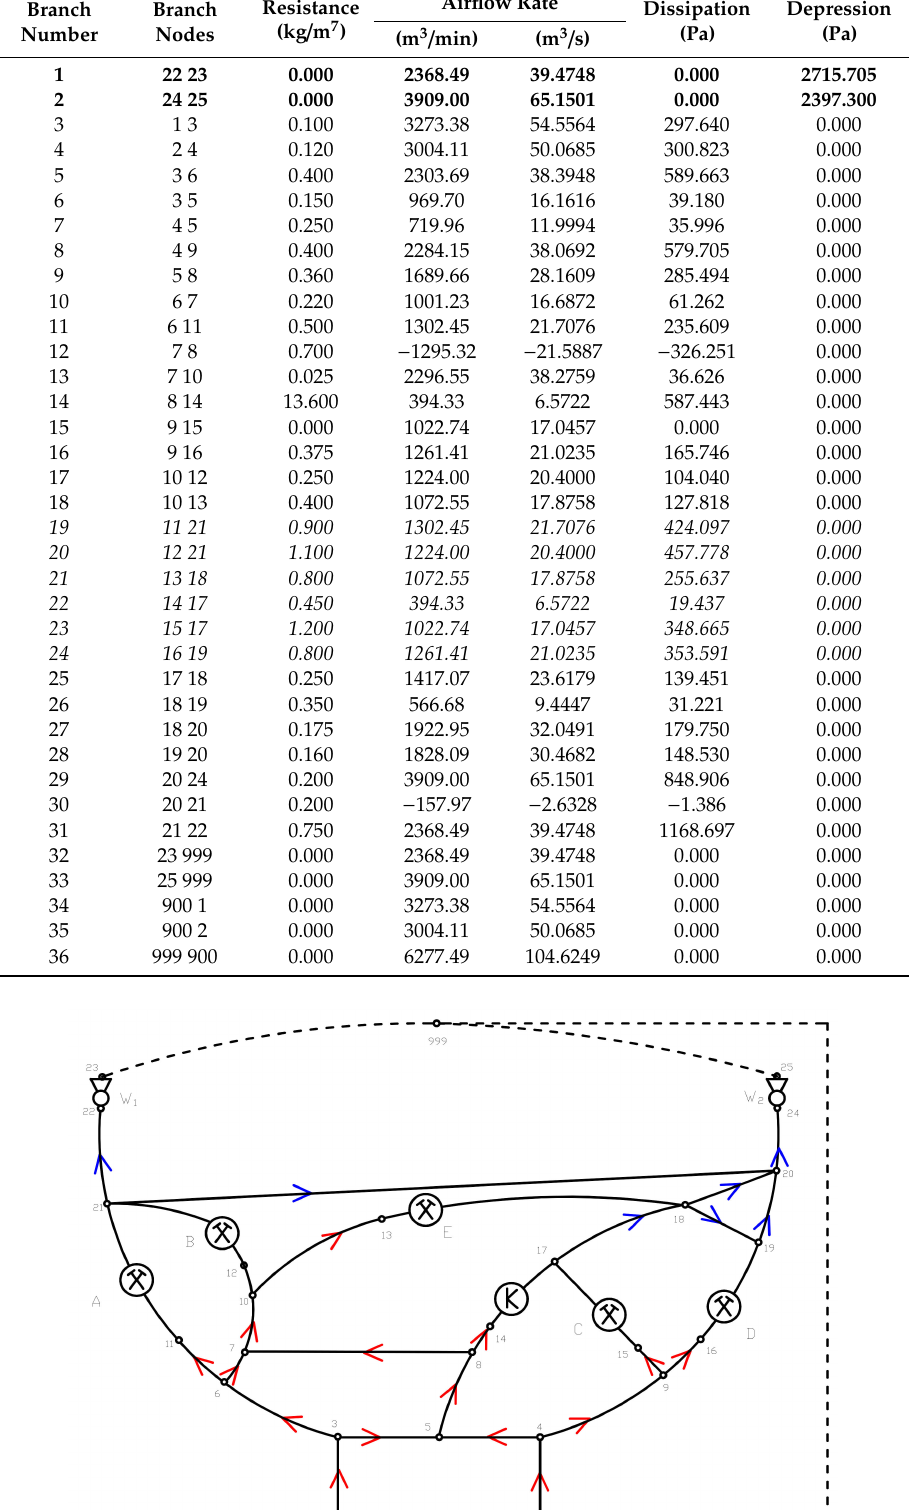
Table 3. Airflow distribution in mine B in the case of normal ventilation (own work).